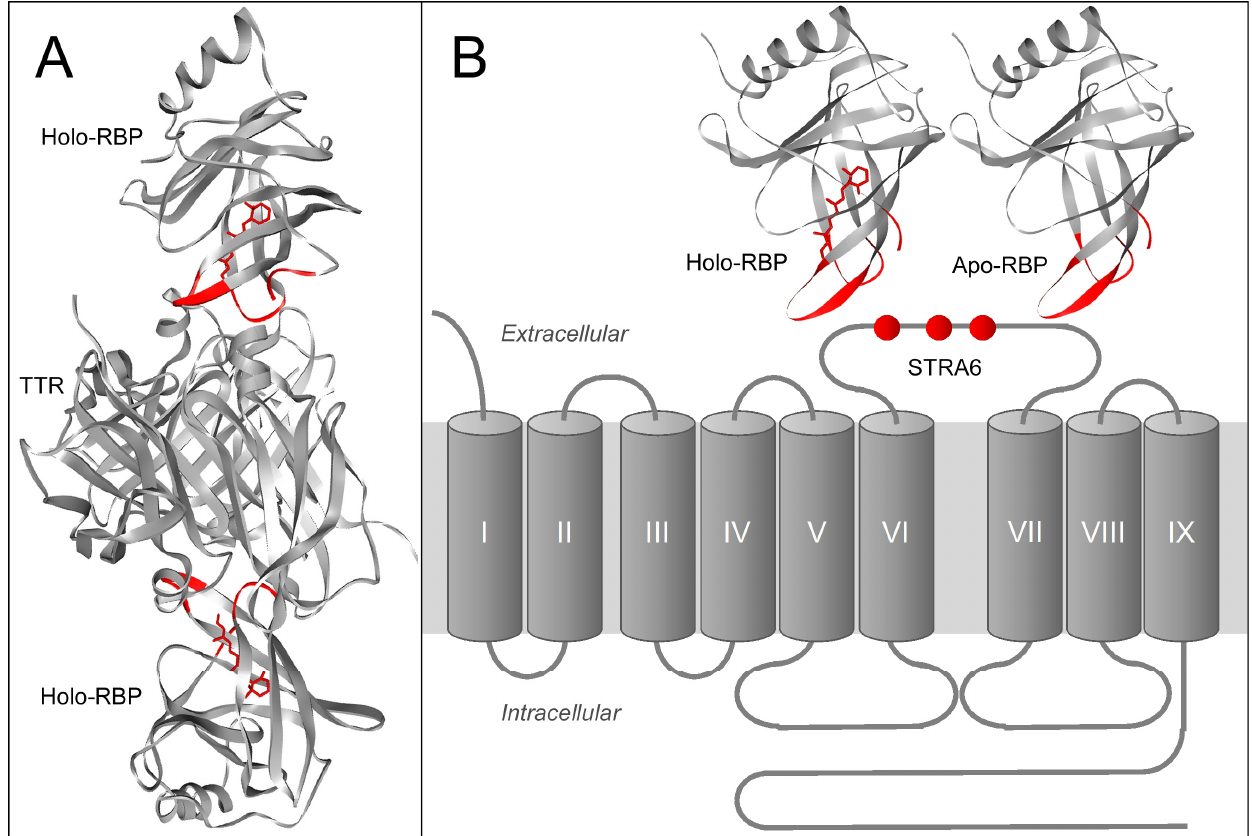
Figure 8. Comparison of RBP’s interaction with TTR and RBP’s interaction with STRA6. Both TTR and STRA6 interact with the vitamin A exit end of RBP. A. Crystal structure of RBP/TTR complex. TTR interacts with only holo-RBP, but not apo-RBP. B. STRA6 binds to both holo-RBP and apo-RBP. The three residues known to be essential for RBP/STRA6 interaction are labeled in red in the STRA6 topology model. In both A and B, residues located at the vitamin A exit end of RBP are labeled in